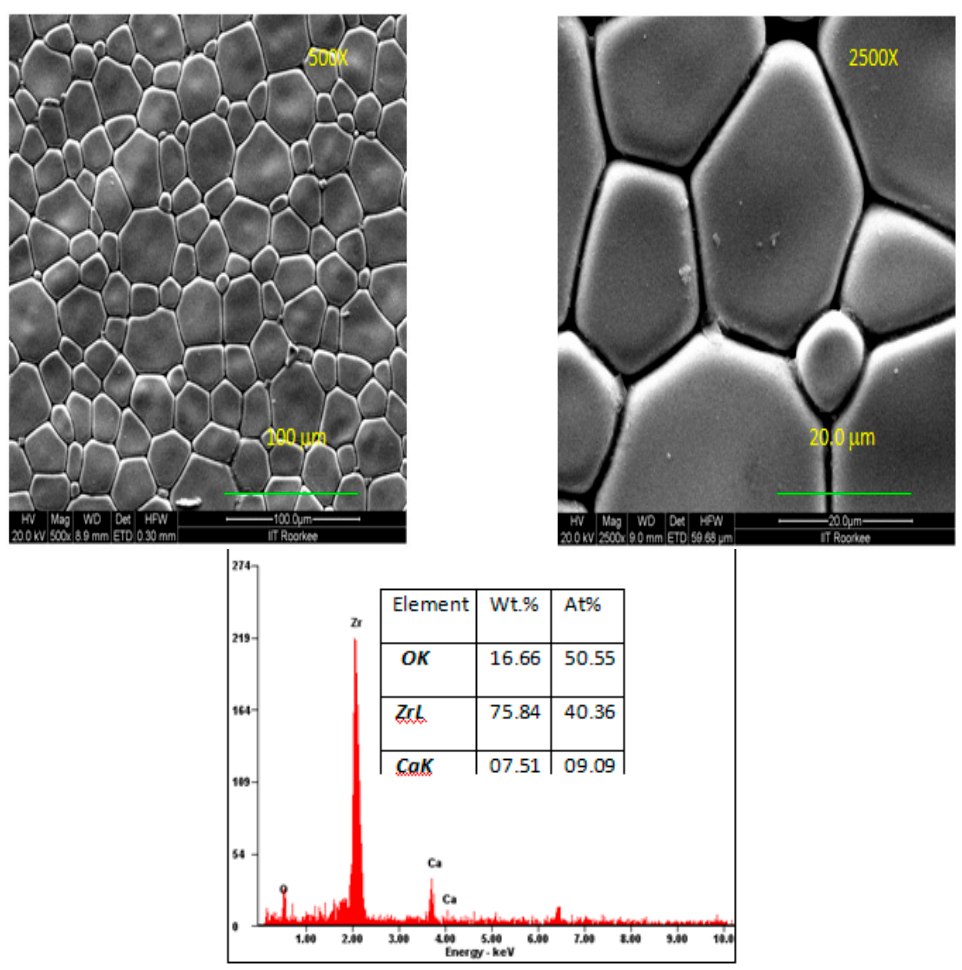
Figure 6. Fifteen mol% CaO-stabilised zirconia SEM and EDS.